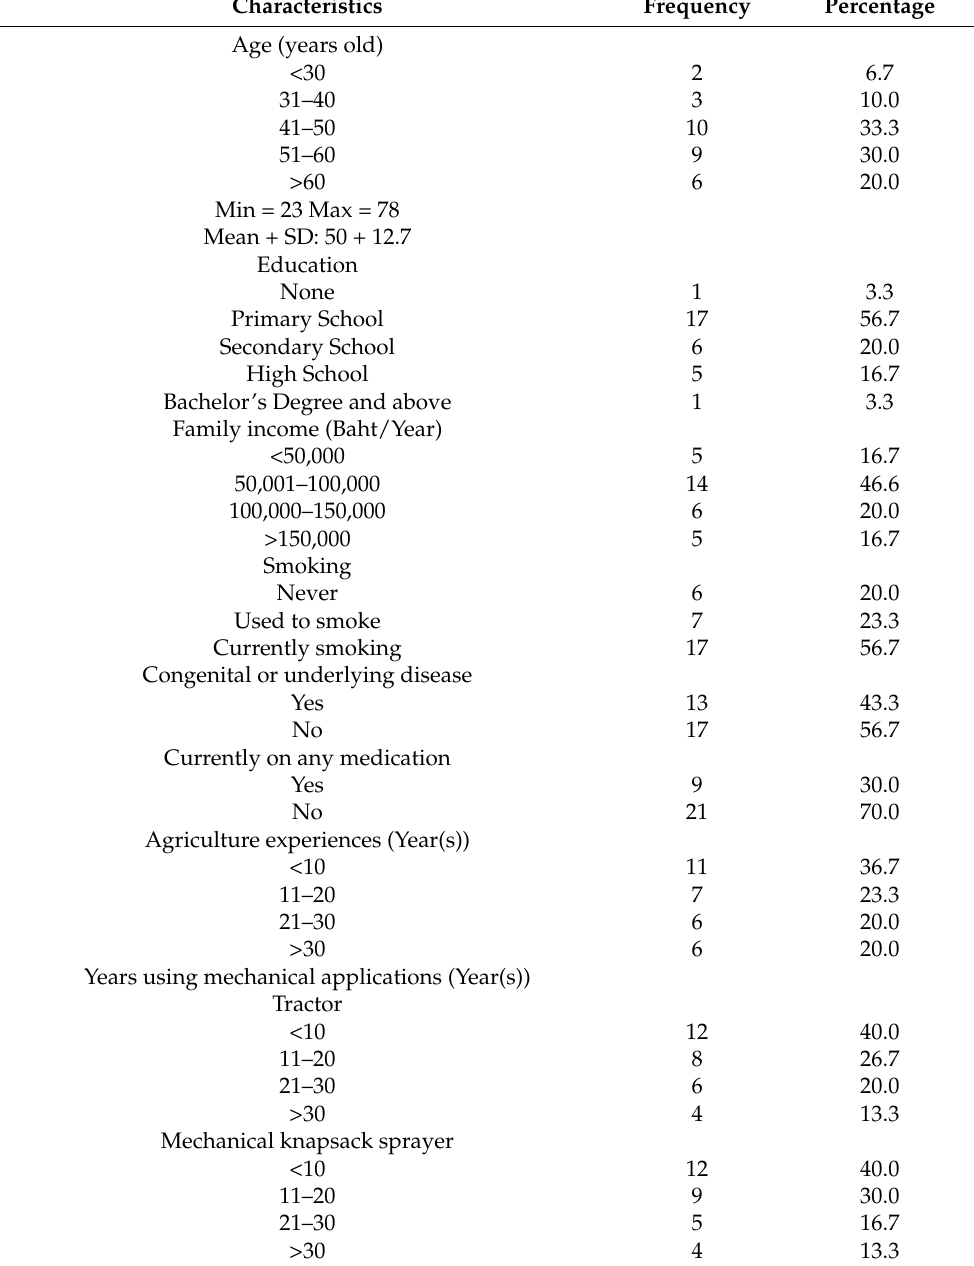
Table 1. Sociodemographic and occupational experience of the respondents ( n =